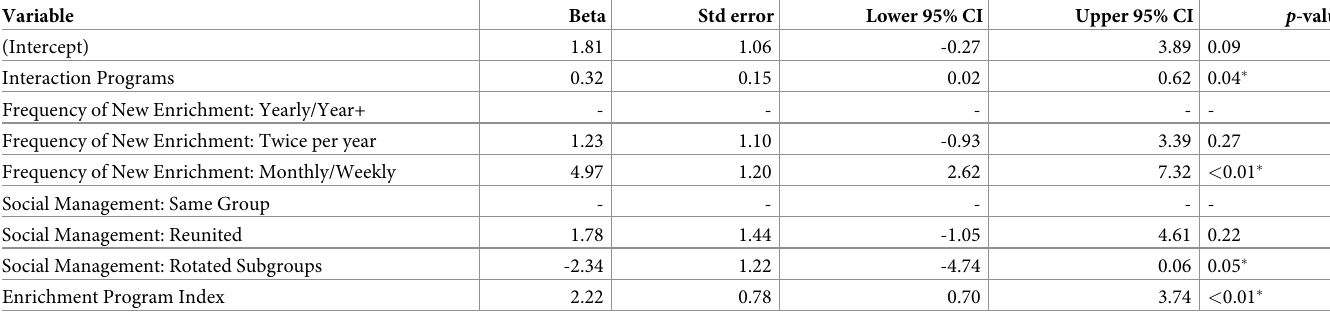
Table 8. Results for the full multivariate model examining bottom third habitat use.